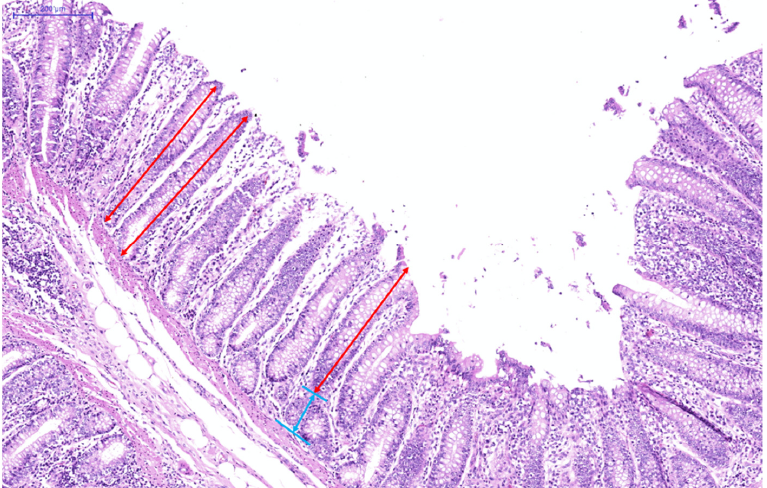
Figure 1. Representative histological pictures of the small intestine, magnified 80×. Red lines represent villus height; blue lines represent crypt depth.